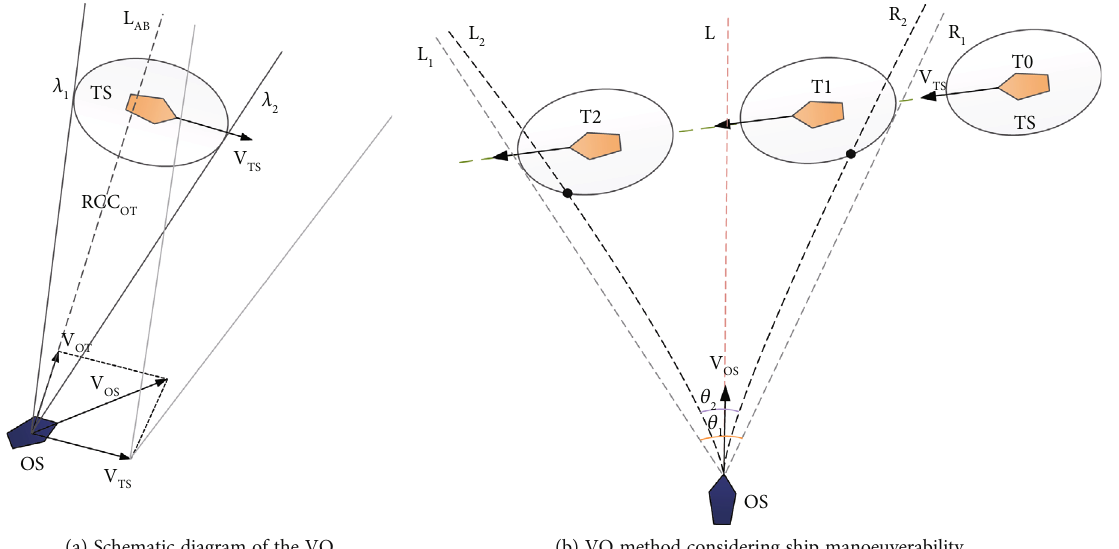
Figure 7: Illustration of VO